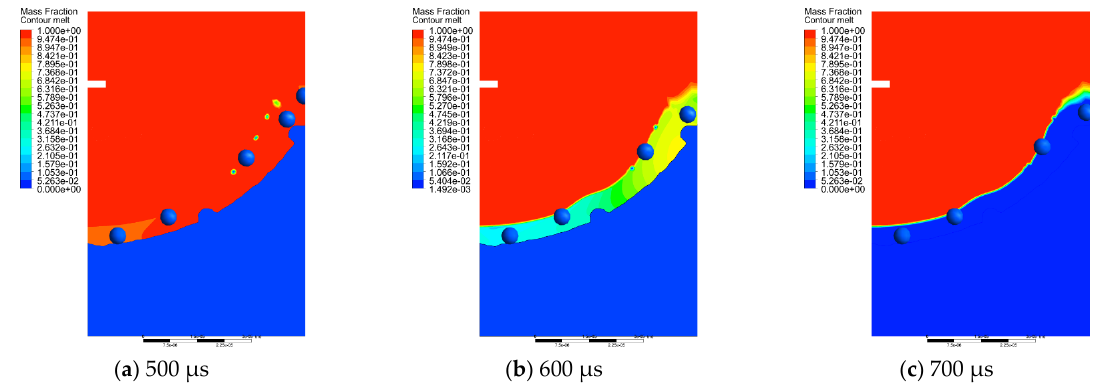
Figure 12. Phase of solidification process of molten metal at different moments.